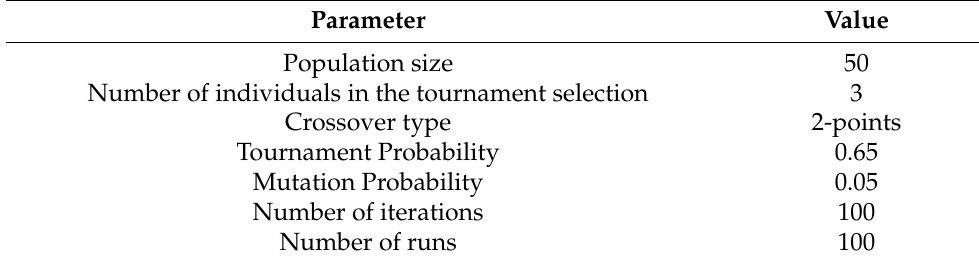
Table 3. Parameter Setting for